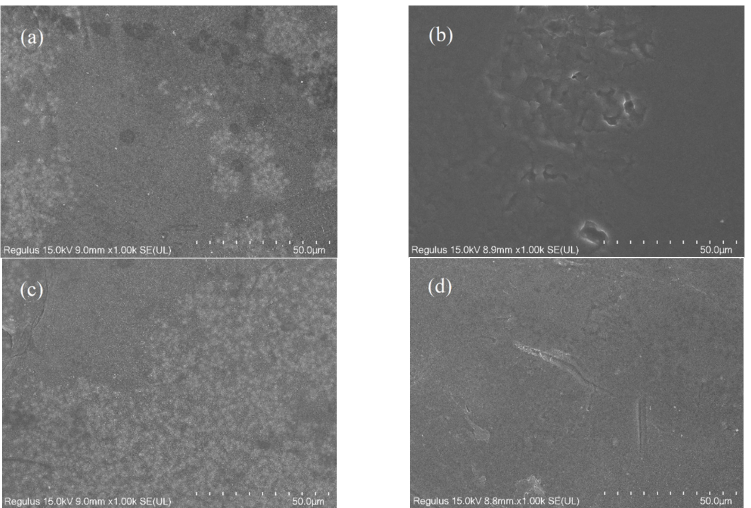
Figure 3. SEM images of the active layer of FO membrane. ( a ) Original membrane; ( b ) Citric acid; ( c ) Potassium sorbate; ( d ) Sodium benzoate.